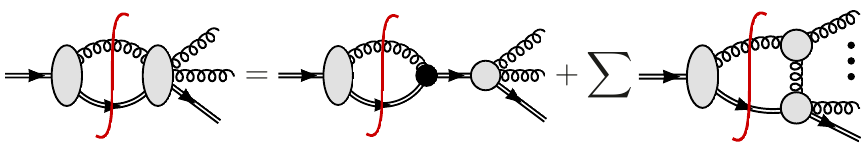
Figure 1 . Decomposing the tree amplitude appearing on the left hand side of a wavefunction cut reveals a divergent